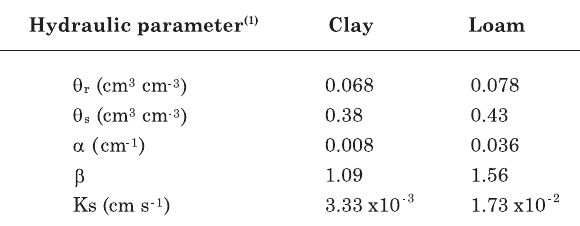
Figure 3. Distribution of the materials within the columns according to the iterations of the Cantor Bar. In (a) CLAY0 (left) and LOAM0; in (b) CLAY1 (left) and LOAM1; in (c) CLAY2 (left) and LOAM2; in (d) CLAY3 (left) and LOAM3; in (e) CLAY4 (left) and